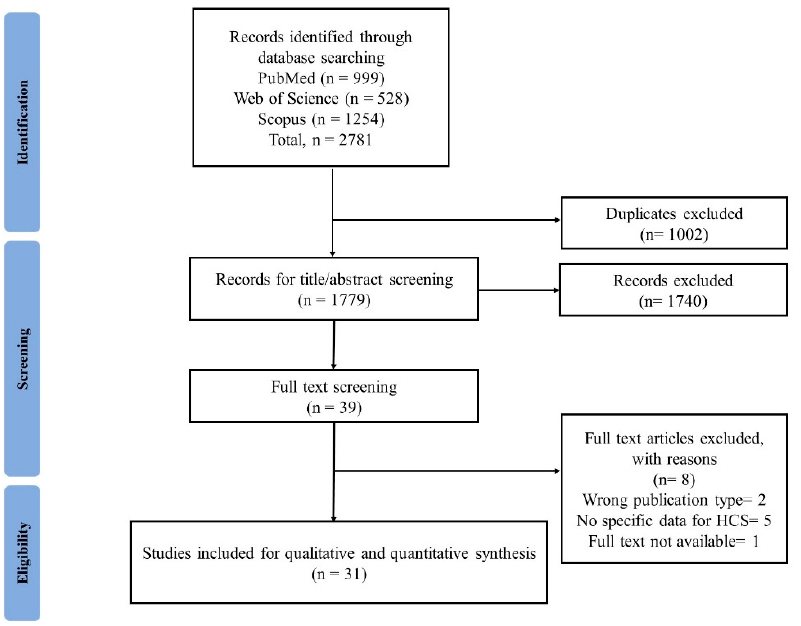
Figure 1. PRISMA flow diagram of the study selection process.